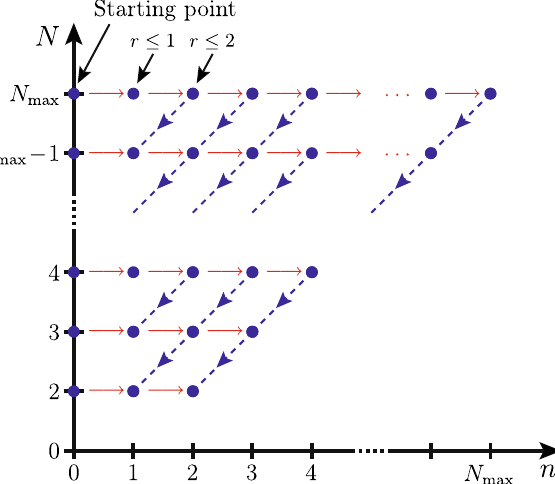
Fig. 12 Evolution of the total number N of loop segments and the number n of dressed segments during the open-loop recursion. Hori- zontalanddiagonalarrowsdescribe,respectively,dressingstepsandthe generation of pinched subtopologies in the on-the-fly reduction. Corre- sponding unpinched contributions, where the rank is reduced but ( N , n ) remainsunchangedarenotshown.Thealgorithmstartsat ( N max , 0 )